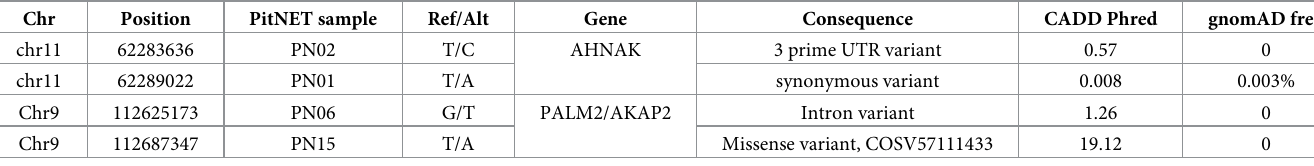
Table 3. Somatic variants found in the same gene and in more than one PitNET